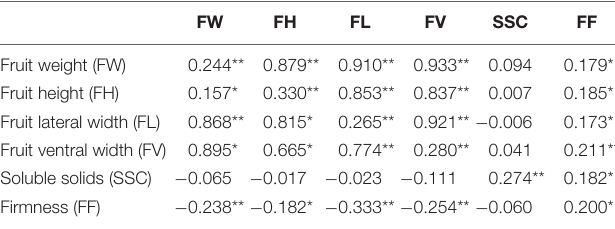
TABLE 1 | The pearson correlation coefficient for different fruit quality traits in 2018 and 2019. FW FH FL FV SSC FF